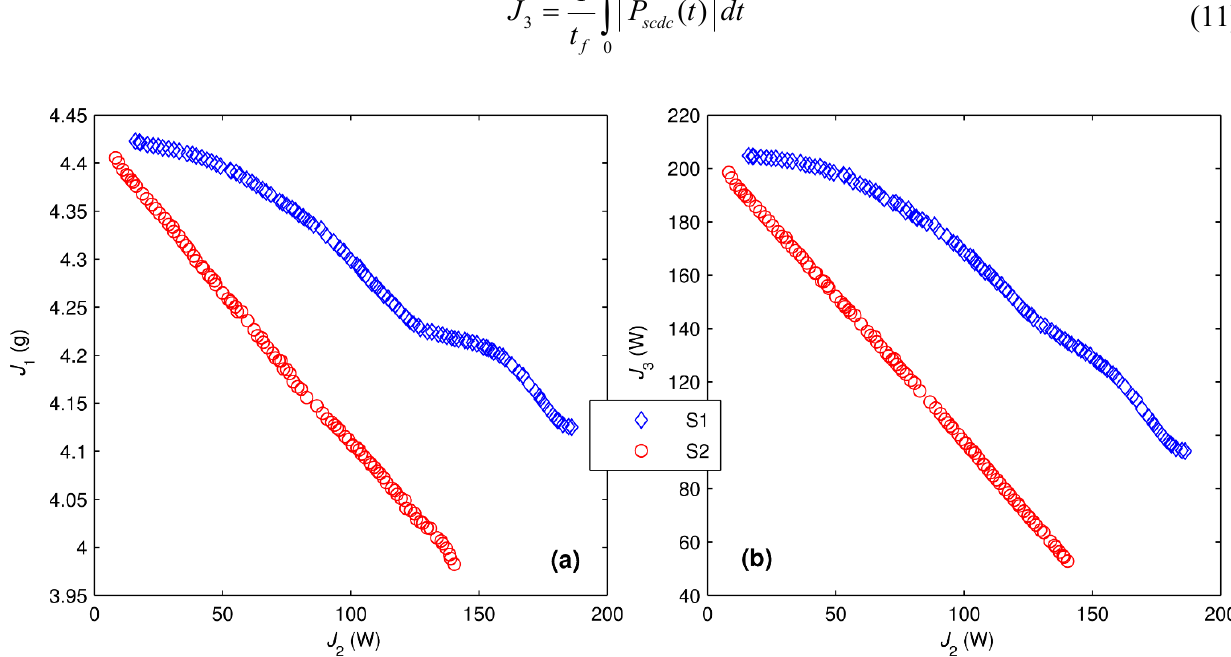
Figure 8. Optimization results of the power management strategies over Manhattan driving cycle. ( a ) Pareto front of J 1 and J 2 ; ( b ) J 3 versus J 2 for the Pareto solutions. The functions J 1 , J 2 and J 3 are defined by Equations (10) and